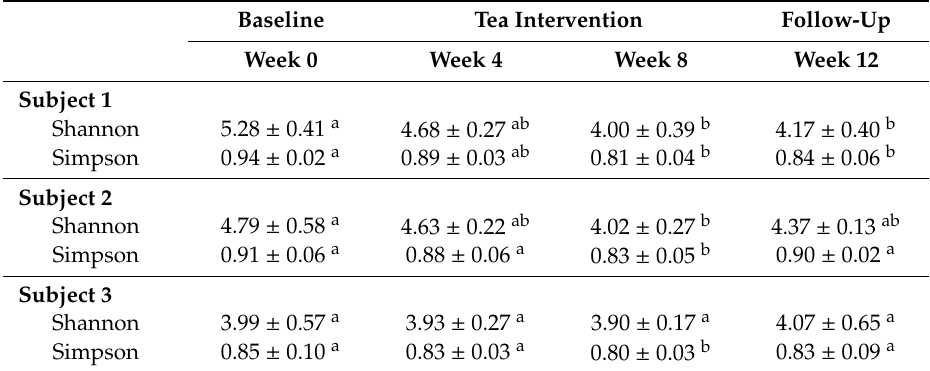
Table 2. The temporal changes of the salivary microbial community diversity in each subject.